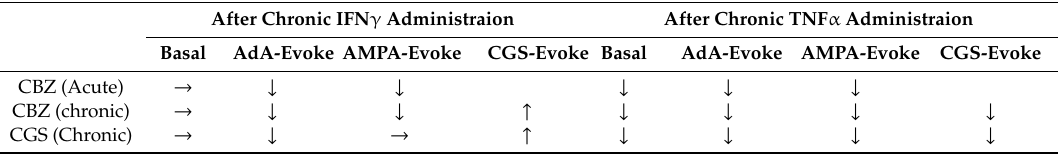
E ff ects of CBZ and CGS21680 on Astroglial L-Glutamate Release after Chronic Cytokine